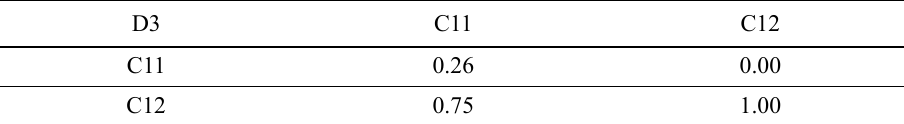
Table 8. The weight matrix of inner dependence for criteria under the Specificity Dimension D3 C11 C12 C11 0.26 0.00 C12 0.75 1.00